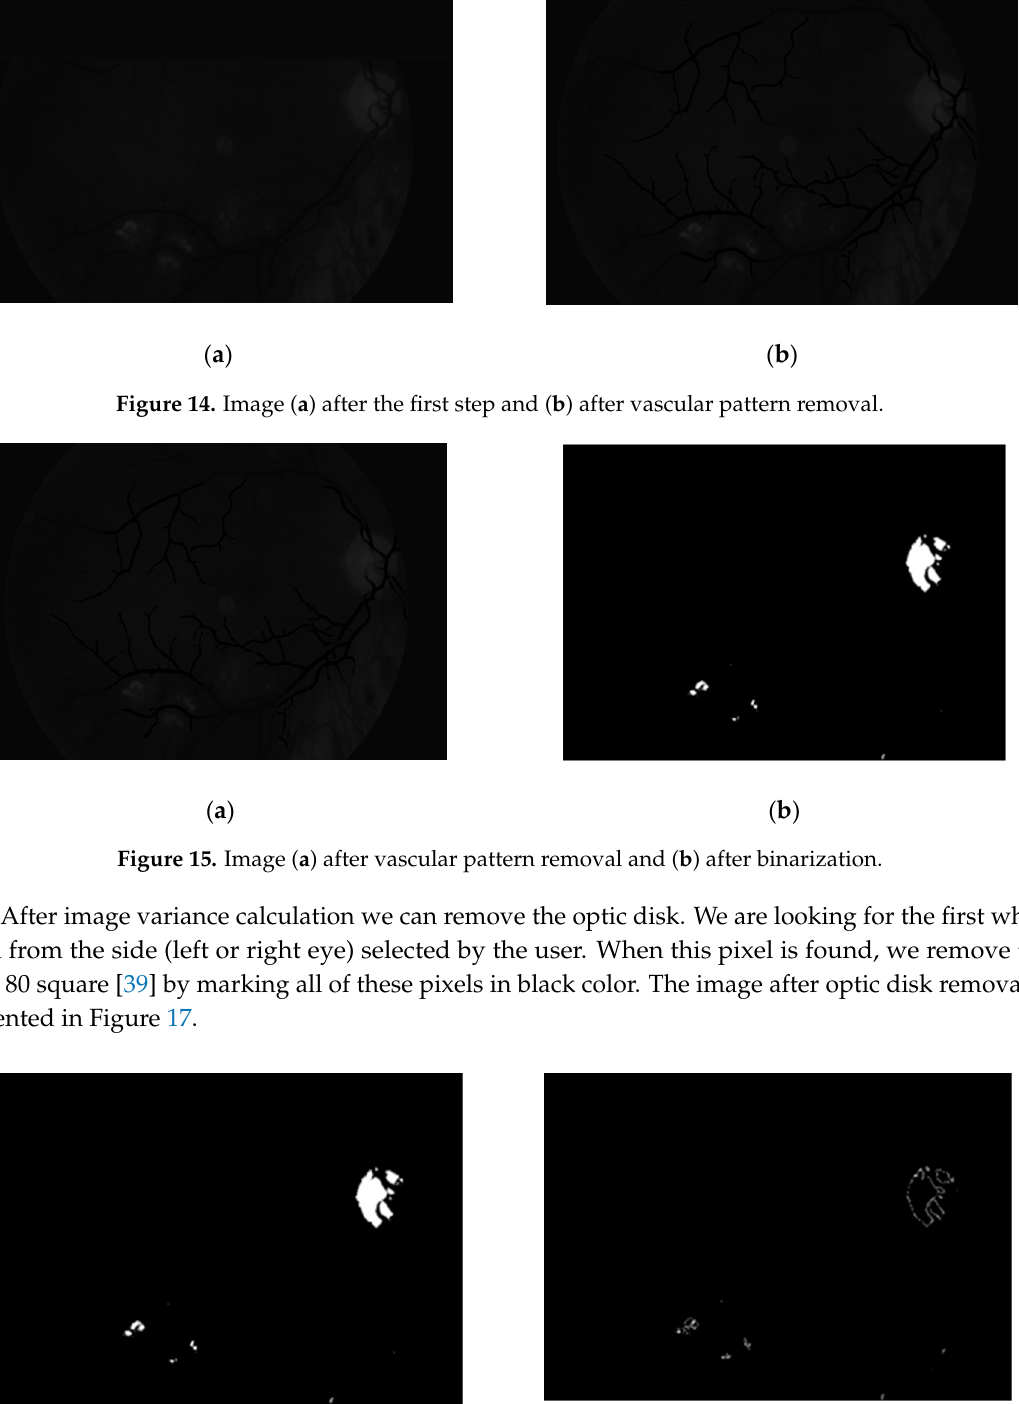
Figure 16. Image ( a ) after binarization and ( b ) calculated image variance.